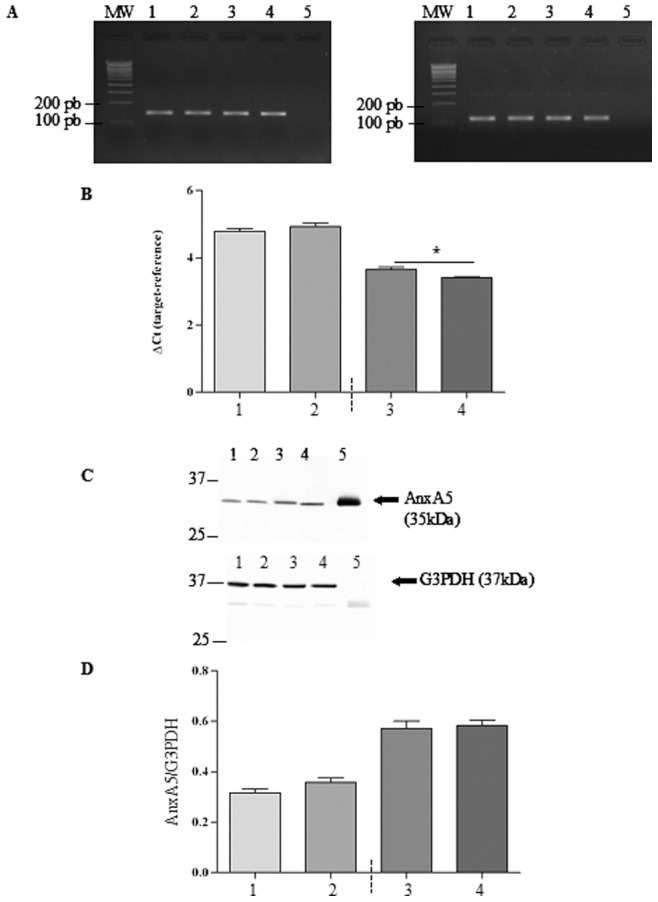
Basal mRNA and protein expression of AnxA5.
A. The left image shows representative PCR bands for AnxA5 (149 bp) and the right image shows representative PCR bands for G3PDH (121 bp, 2% agarose gel). A single band is observed in 16HBE14o− (lane 1), CFBE41o− (lane 2), CFBE41o−/corr (lane 3) and CFBE41o−/F508del (lane 4) cells. No signal is observed in the negative control (lane 5). MW is the molecular weight given in base pairs (bp). B. The gene expression of AnxA5 was determined by quantitative Real-Time PCR in each cell line and data were analyzed by using ΔCt (target – reference). Comparison between CFBE41o−/corr (3) and CFBE41o−/F508del (4) cells show a higher expression in CF cells. C. The upper image shows a representative immunodetection of AnxA5 protein (35 kDa) and the lower image shows the immunodetection of G3PDH (37 kDa) protein expression in 16HBE14o− (lane 1), CFBE41o− (lane 2), CFBE41o−/corr (lane 3) and CFBE41o−/F508del (lane 4) cells. Pure AnxA5 was used as a positive control (lane 5). G3PDH was detected to show that the loading was identical in each lane and for further normalization. D. Statistical analysis of AnxA5 expression (n = 6) indicate that the expression of AnxA5 does not vary among cell lines although it tends to be higher in CFBE41o−/corr and CFBE41o−/F508del cells than in 16HBE14o− or CFBE41o− cells.